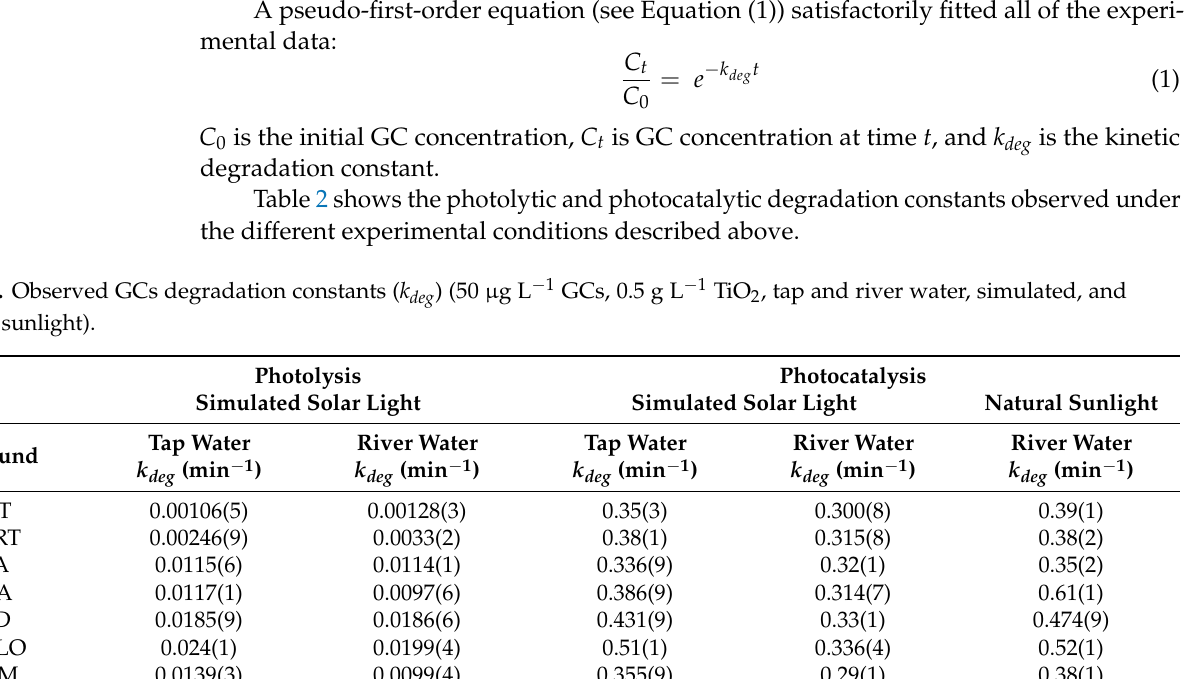
) (see Section 2.3 for the irradiation conditions). (cid:35)